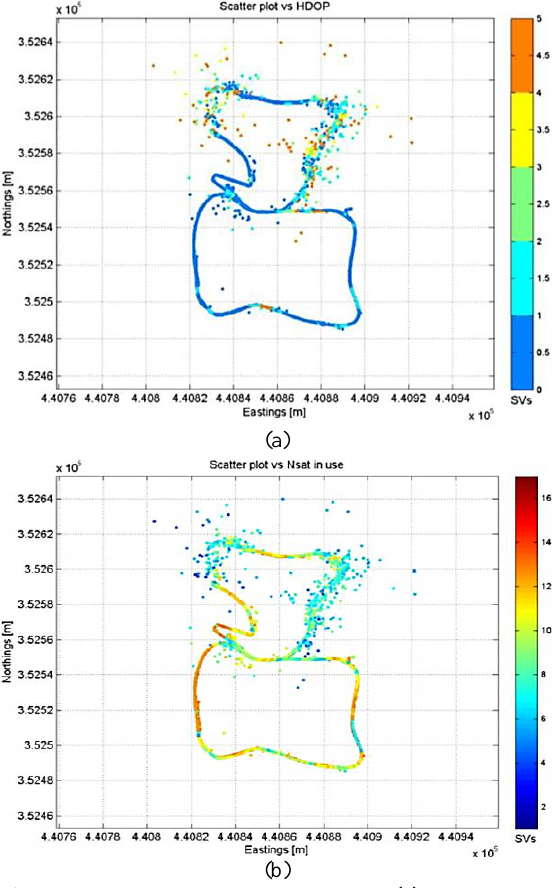
Figure 5. Javad Mobile Kinematic Results: (a) HDOP vs.